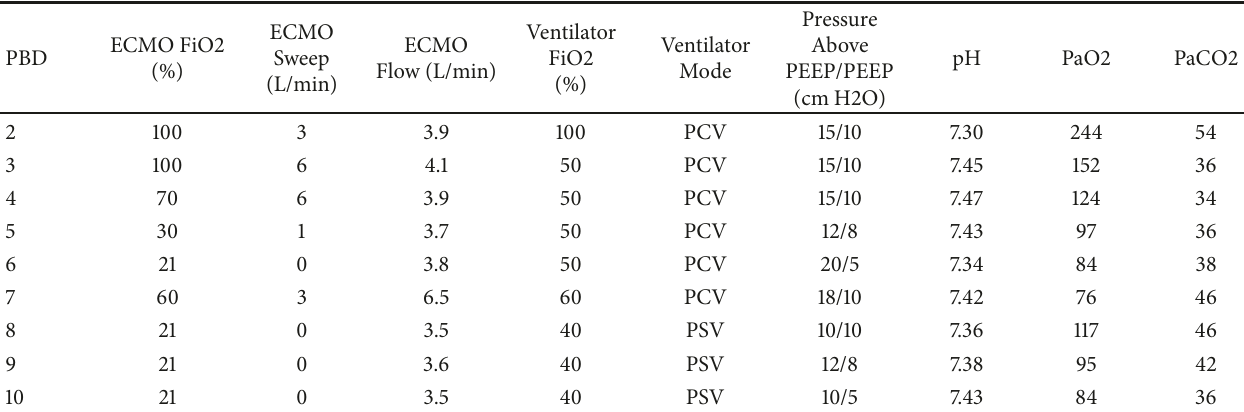
Table 1: Extracorporeal Life Support (ECMO) and Mechanical Ventilation Parameters. ECMO was initiated on PBD 2 and discontinued